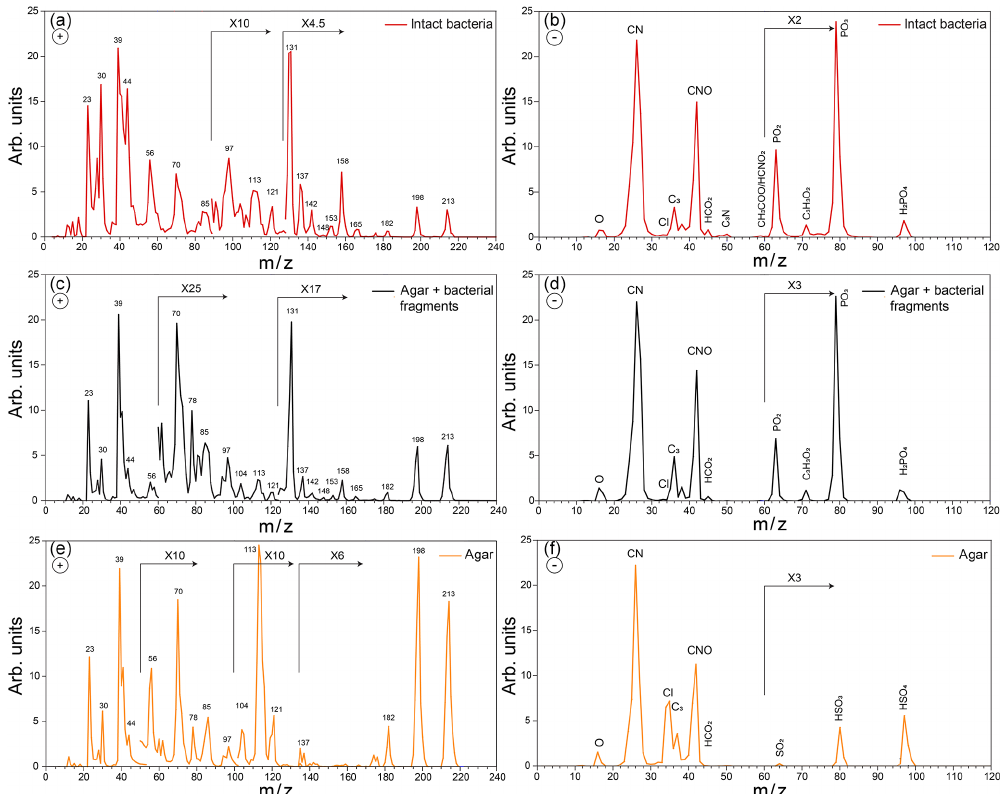
Figure 3. Positive (a) and negative (b) average mass spectra (MS) of intact Pseudomonas syringae bacteria measured before Expansion 1; positive (c) and negative (d) average MS of the small particle mode measured before Expansion 1; positive (e) and negative (f) average MS of pure agar particles measured in a separate